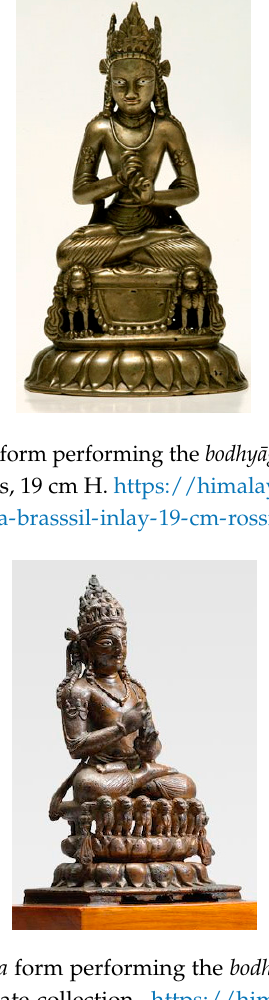
Figure 29. Vairocana in sambhogak ā ya form performing the bodhy ā gr ī mudr ā , eighth to ninth c. Swat. Bronze with silver inlay. 12.7 cm H. Private Collection. https://himalayanbuddhistart.files.wordpress.com/2012/10/8-9th-c-swat-valley-vairocana-bronzesil- eyes-127-cm-christies.jpg. Figure 30. Vairocana in sambhogak ā ya form performing the bodhy ā gr ī mudr ā , ninth to early 10th c. From Pakistan (possibly Gilgit region). https://en.wikipedia.org/wiki/Gandharan_Buddhism#/media/ File:MET_DT5714.jpg. 5.2. Representations of Mah ā vairocana: Dharmacakra-Pravartana Mudr ā Some scholars have argued that a figure can only be identified as Vairocana if he is performing the bodhy ā gr ī mudr ā . However, there is another mudr ā that acts as an iconographic signifier to identify Vairocana, although it is perhaps less known. It is the dharmacakra-pravartana mudra (Snellgrove 1978; Huntington and Chandrasekhar 2000; Von Schroeder 2001). This mudr ā refers to the turning or